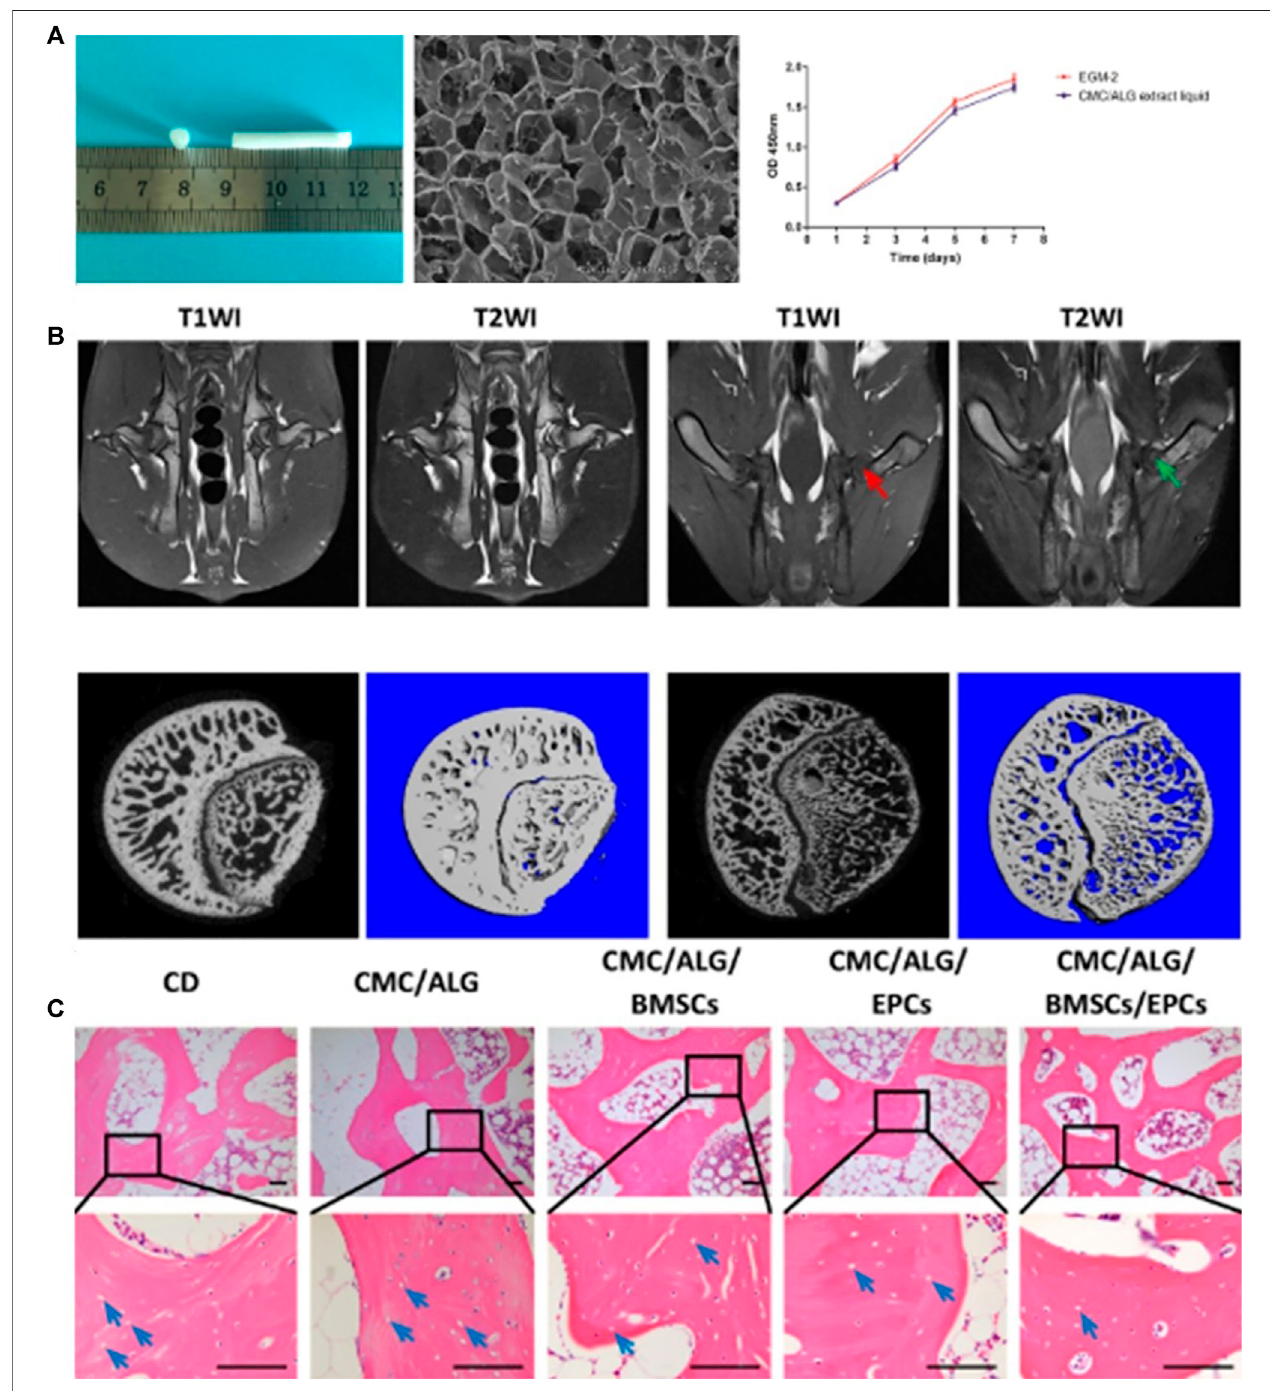
FIGURE 1 | BMMSC and EPCs dual-loaded CMC/ALG scaffolds for enhanced bone regeneration in ONFH (Xu et al., 2021). (A) Morphology of the scaffold for in vivo transplantation. The SEM micrograph showed the porous structure of the scaffold. And CCK-8 assay results con fi rmed that CMC/ALG scaffolds generated no cytotoxicity effects on BMSC/EPC viability. (B) Representative MRI photograph of the normal rabbit and the rabbit model. 2D and 3D micro-CT images of the femoral headinnormalgroupandmodelgroup. (C) H&Estainingoftheemptylacunainthenecroticregionofthefemoralheadforeachgroup.Reproducedwithpermission (Xu et al., 2021). Copyright 2021, Wiley Periodicals